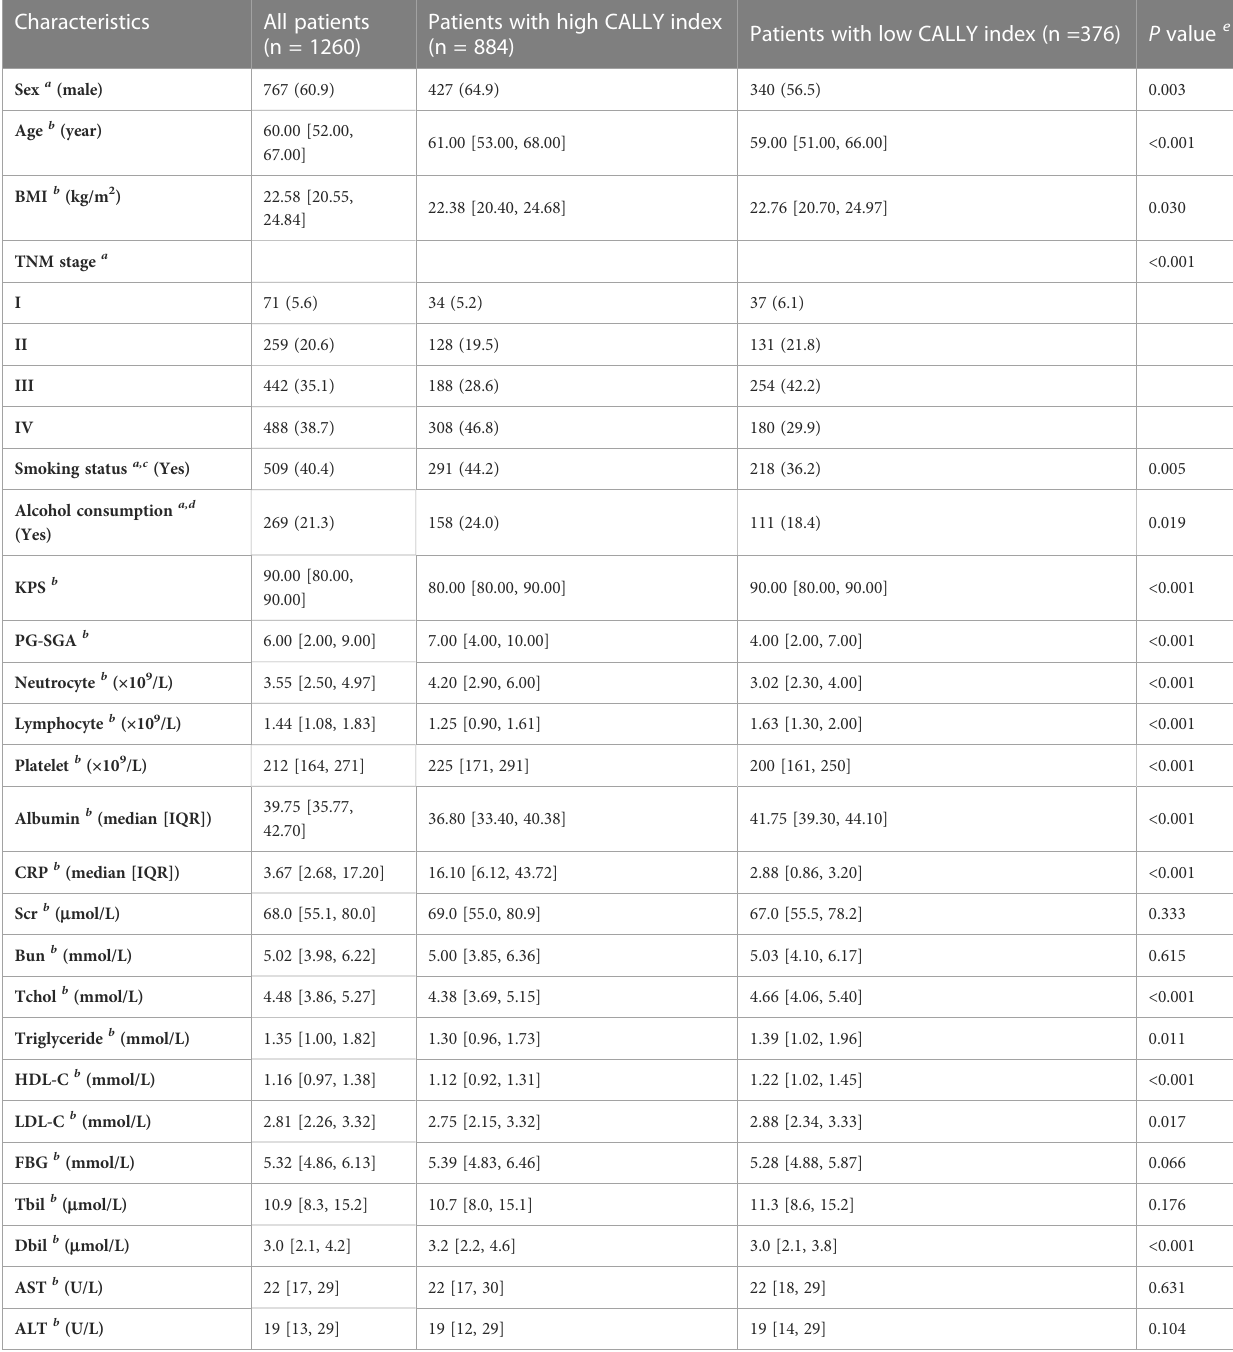
TABLE 1 Characteristics of all patients, patients with high and low CALLY index.